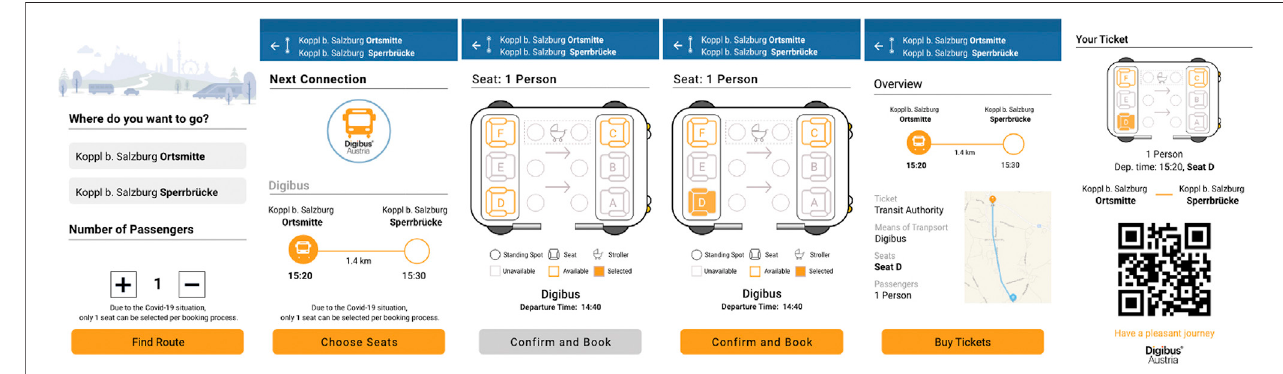
FIGURE 10 | Study 3: Interaction overview of the iterated